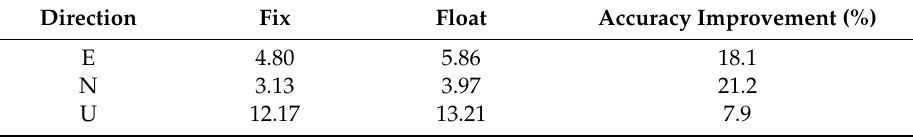
Table 6. The average accuracy of BDS kinematic PPP for 10 stations (Unit: